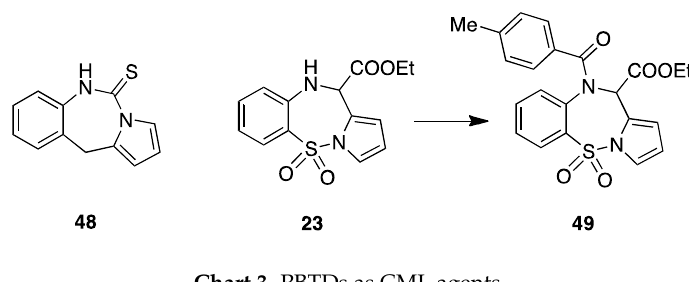
Chart 3. PBTDs as CML agents. Table 2. Apoptotic activity of 23 and 49 in cells from CML patients at onset at 10 μ M [46].